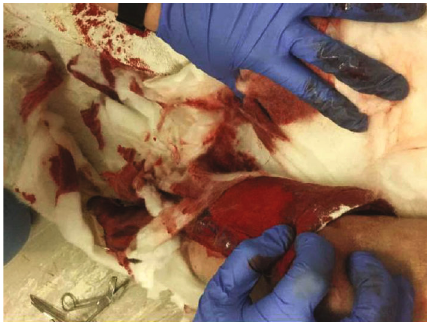
Figure 1: Case 1: dog hemorrhage post-intra-articular PPS